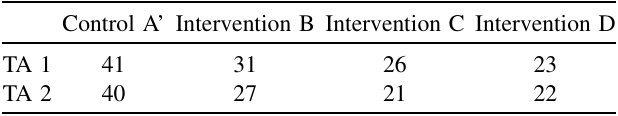
TABLE II. Distribution of students into control and interven- tion groups. TA refers to the teaching assistant.